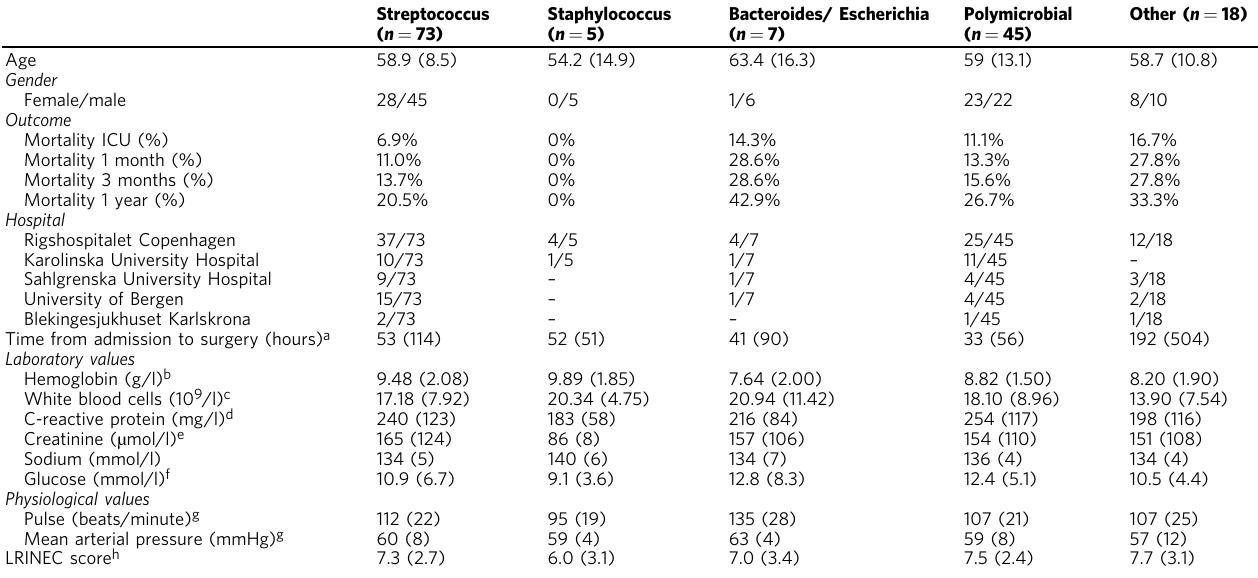
Table 1 Clinical characteristics of patients cohort by infection type